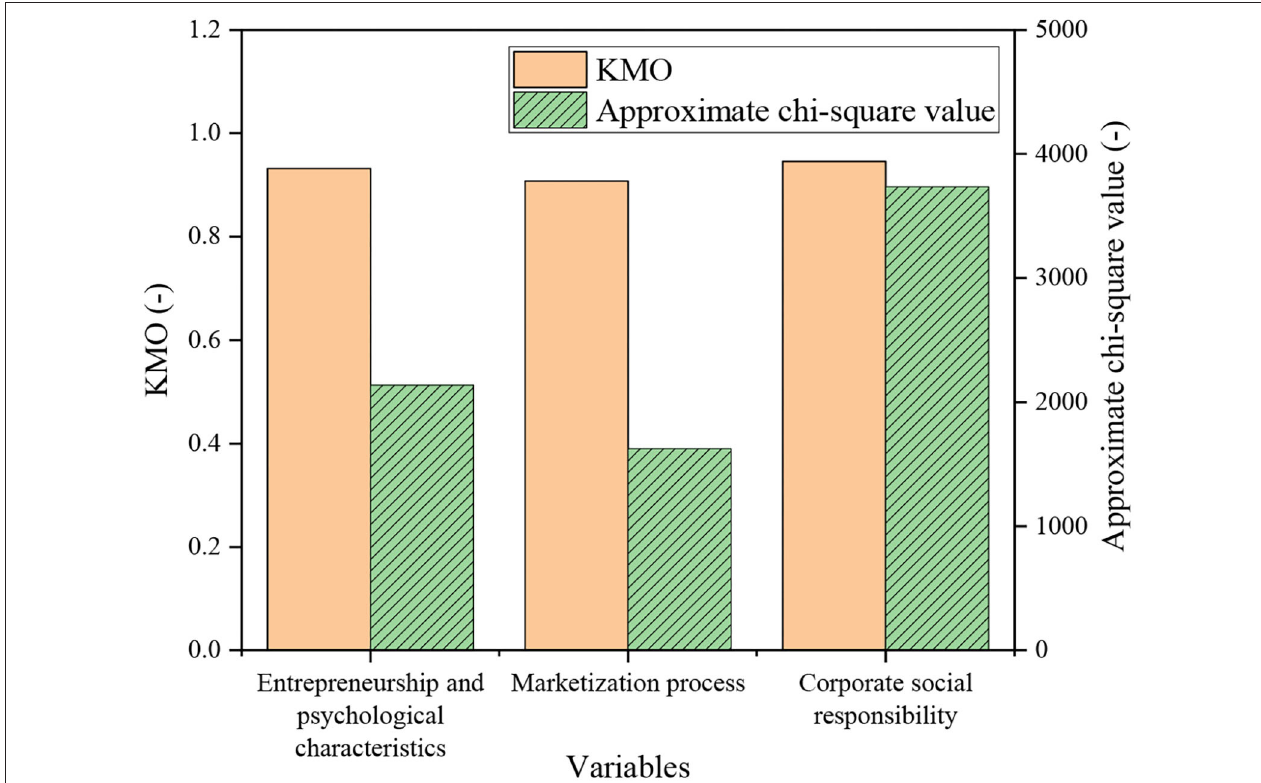
FIGURE 2 | Test results of reliability and validity of the